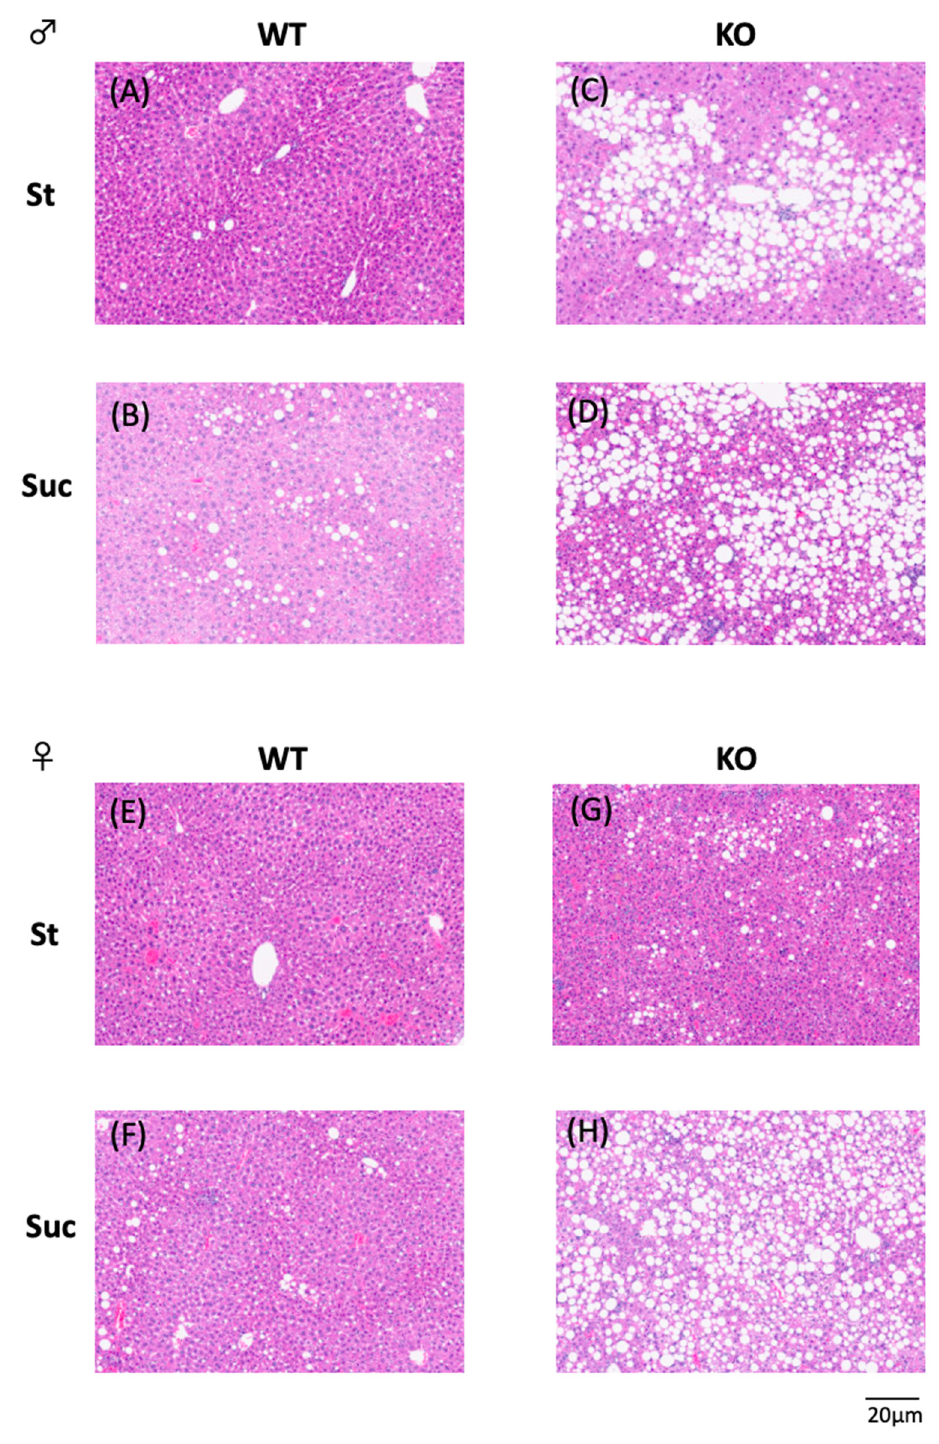
Figure 2. Hematoxylin and eosin (H & E)-stained liver sections from representative mice according to diet. ( A ) St-fed wild-type male mouse. ( B ) Suc-fed wild-type male mouse. ( C ) St-fed PPAR α − / − male mouse. ( D ) Suc-fed PPAR α − / − male mouse. ( E ) St-fed wild-type female mouse. ( F ) Suc-fed wild-type female mouse. ( G ) St-fed PPAR α − / − female mouse. ( H ) Suc-fed PPAR α − / − female mouse. WT, wild-type mice; KO, PPAR α − / − mice; St, starch diet; Suc, high-sucrose diet.